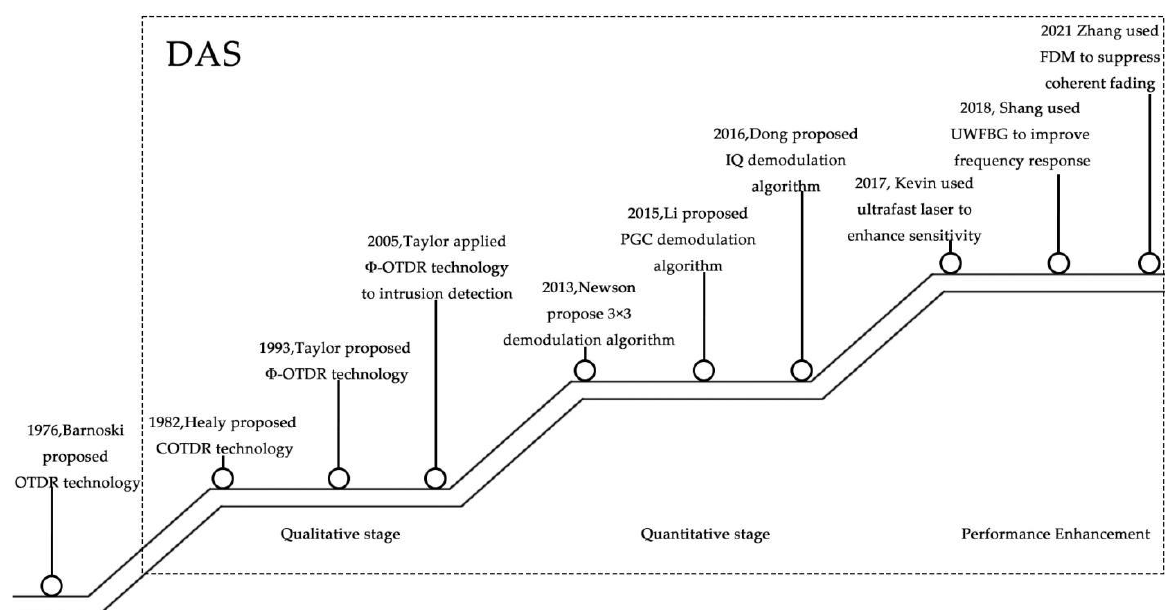
Figure 1. The history of DAS development.